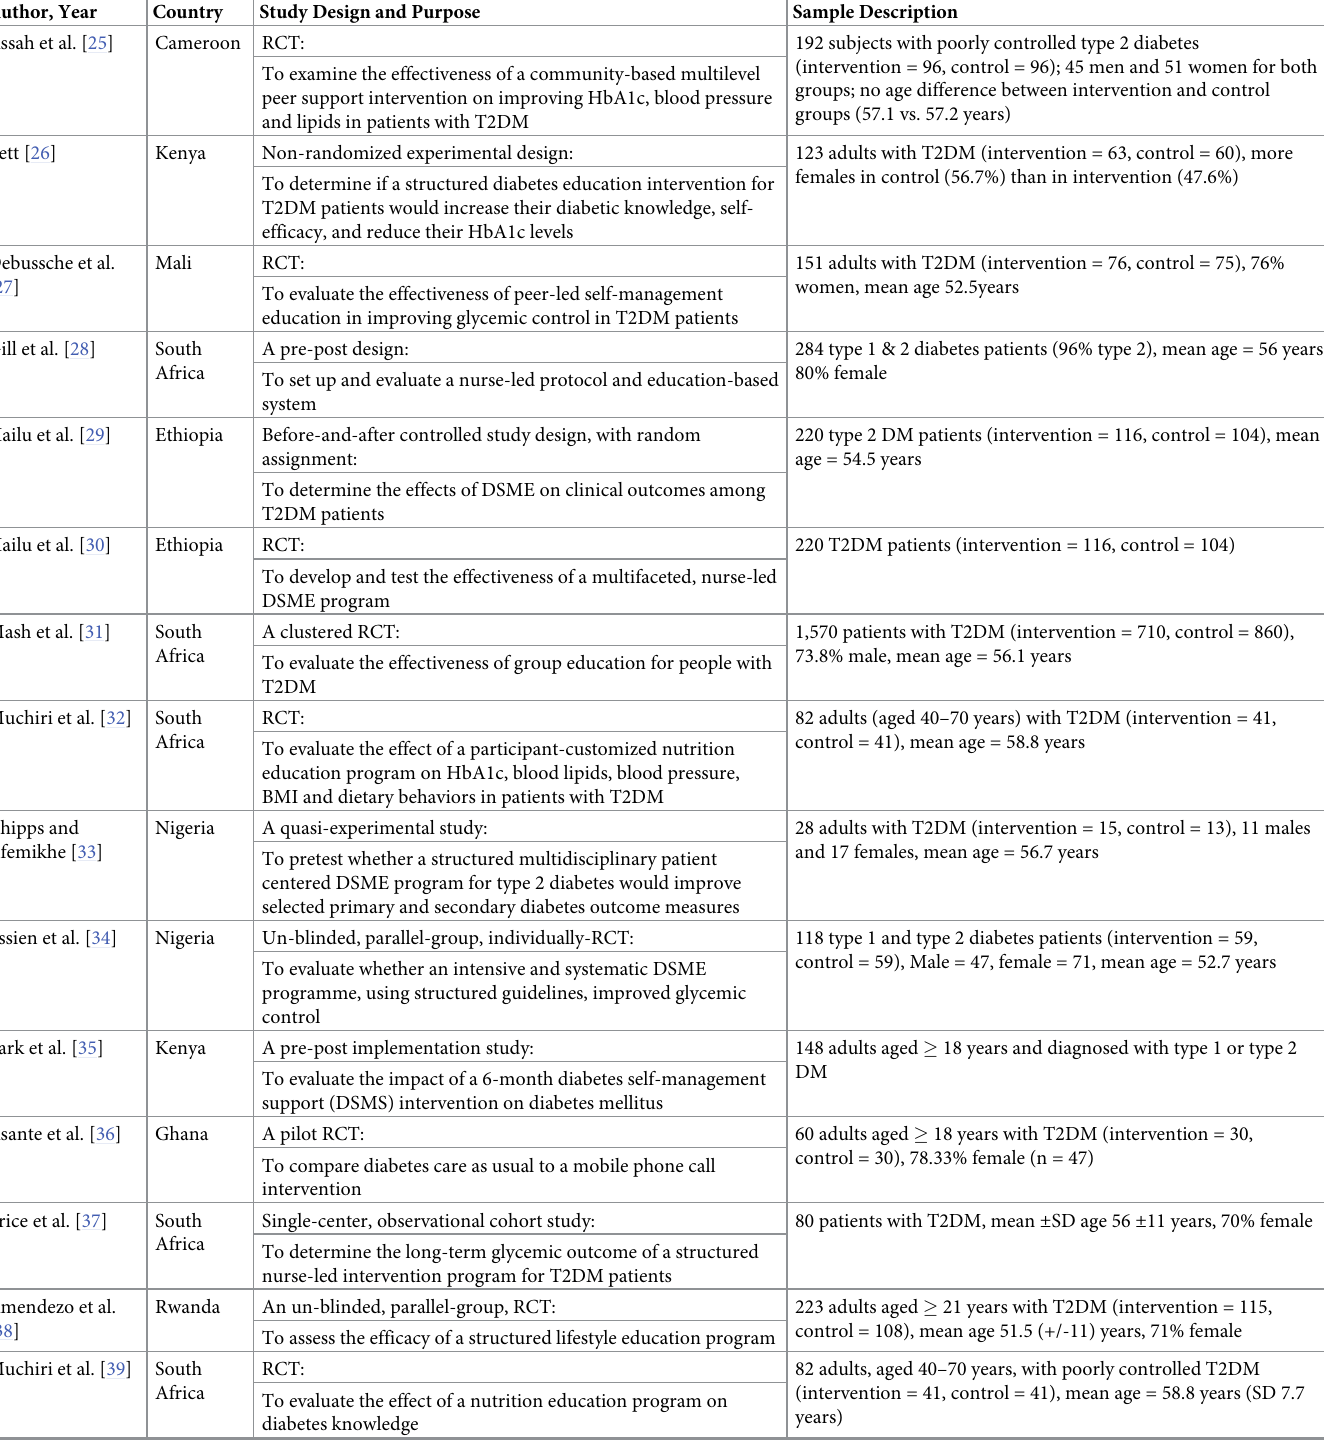
Table 2. Details of the reviewed